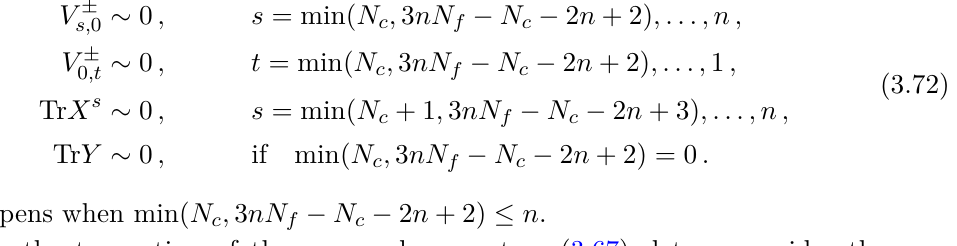
) = (3 , 1) , (3 , 2) are given in appendix B. The SU( N f